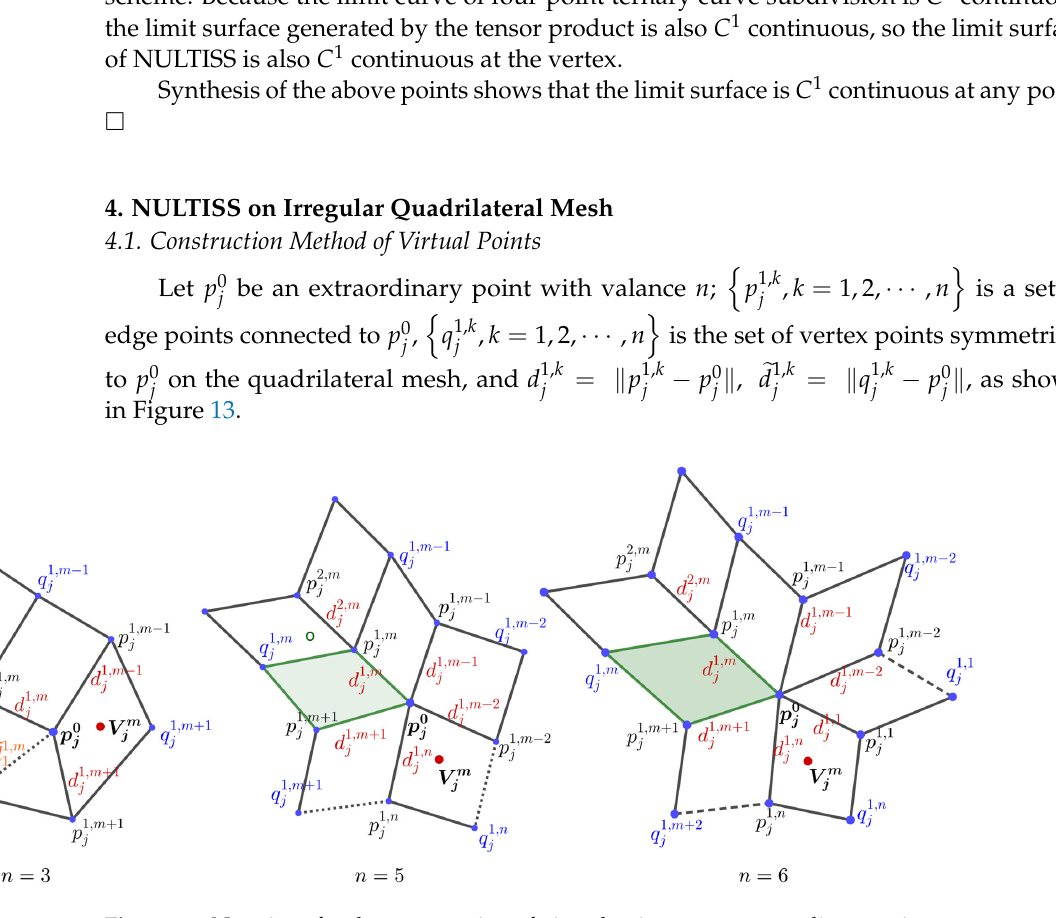
Figure 13. Notations for the construction of virtual points at an extraordinary point.